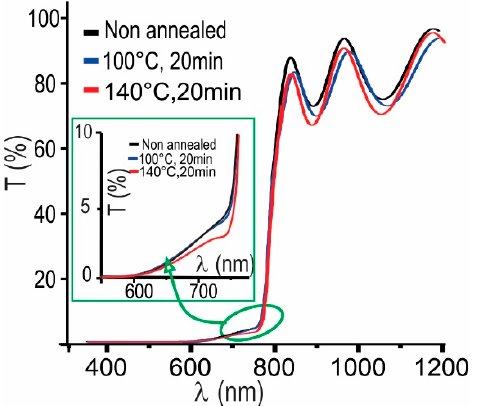
Figure 8. Effect of annealing temperature on the transmittance of a typical MAPI film prepared under a PbI 2 /MAI thickness ratio of 3:1.